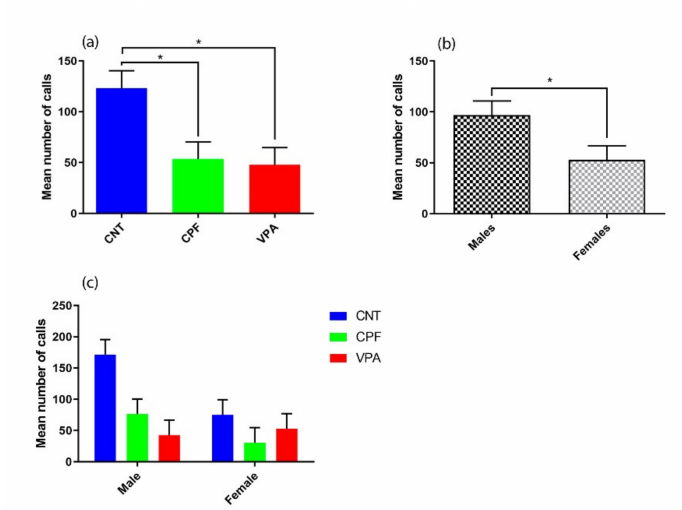
Figure 2. Differences in total number of calls (n = 42): ( a ) There were significant differences according to the prenatal treatment received, with control group (CNT) (n = 14) being significantly different from the other two groups: Chlorpyrifos (CPF) (n = 14) and valproic acid (VPA) (n = 14); ( b ) There was a significant difference between males (n = 21) and females (n = 21); ( c ) There was no significant Treatment * Sex interaction, in spite of the fact that the males of the CNT (n = 7) group tend to emit considerably more calls than any other group (CNT female n = 7; CPF male n = 7; CPF female n = 7; VPA male n = 7; VPA female n = 7), showing more clearly the how the prenatal treatments differentially affect males and females.